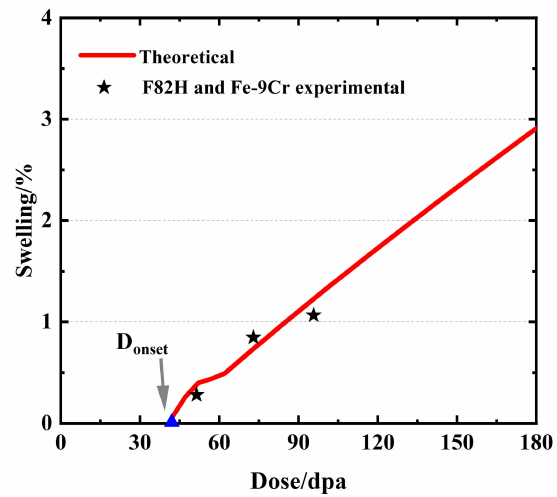
Figure 6. Predicted irradiation swelling of CLAM steel as a function of the dose under neutron irradiation (with low helium production rate in fission reactor) at 400 ◦ C and compared with the experimental data of F/M steels, data from [32,33]. Due to the production of H and He in the fusion reactor, the swelling in the fusion reactor may be higher than in the